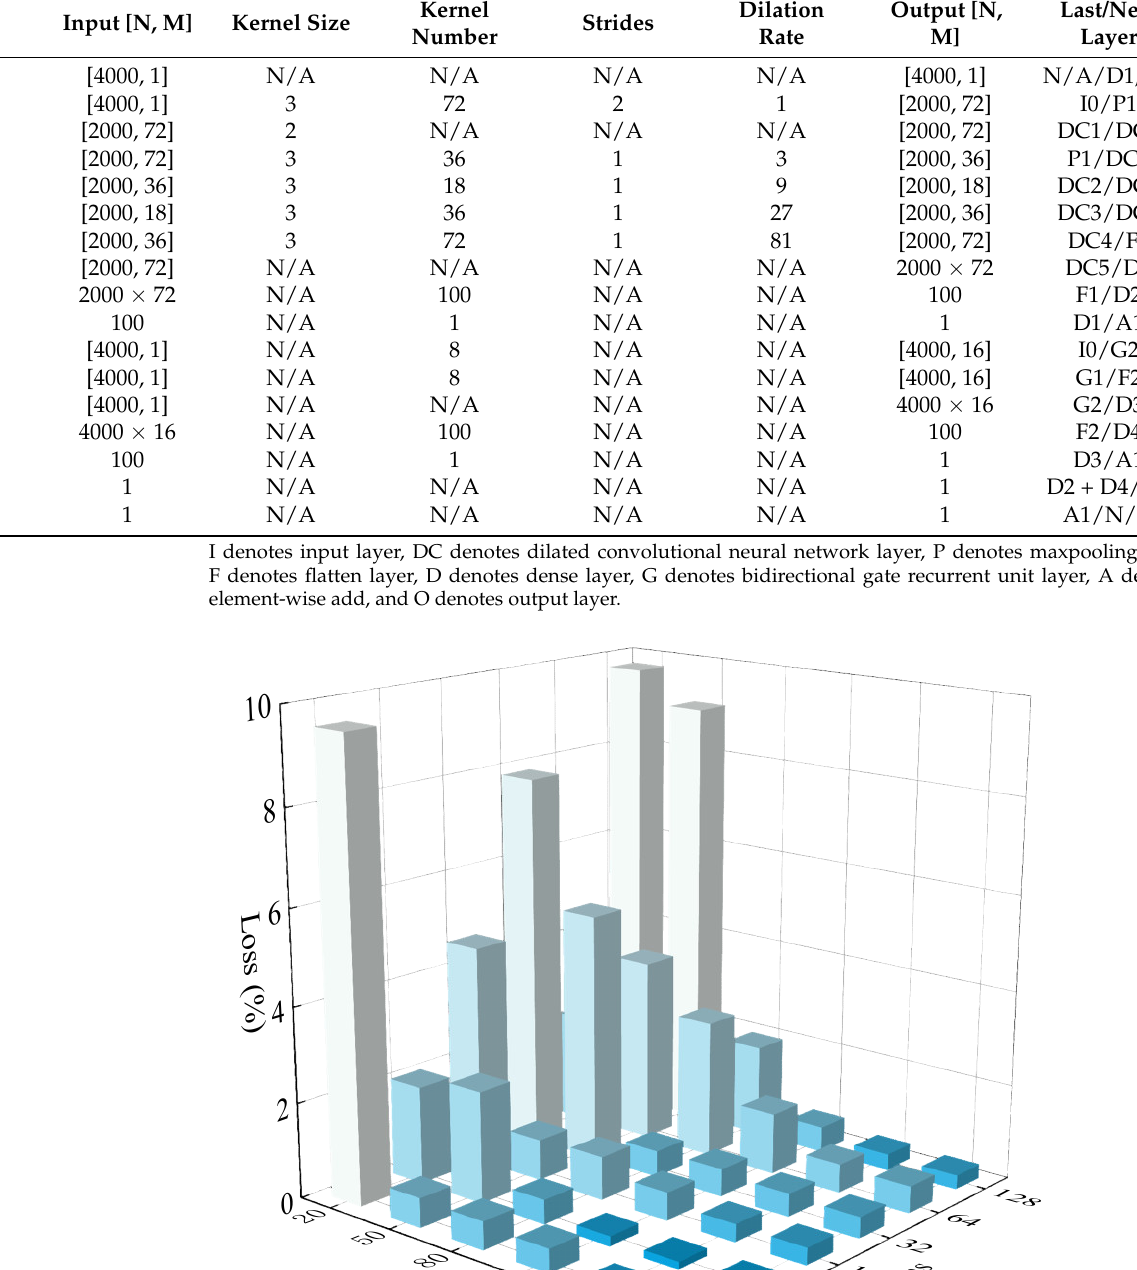
Figure 4. The overall network structure of the proposed dilated CNN-BiGRU.